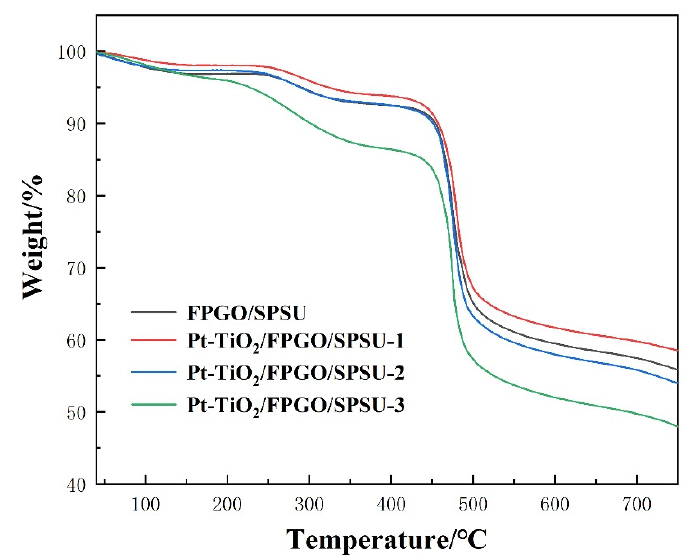
Figure 5. TGA curves of all the membranes.